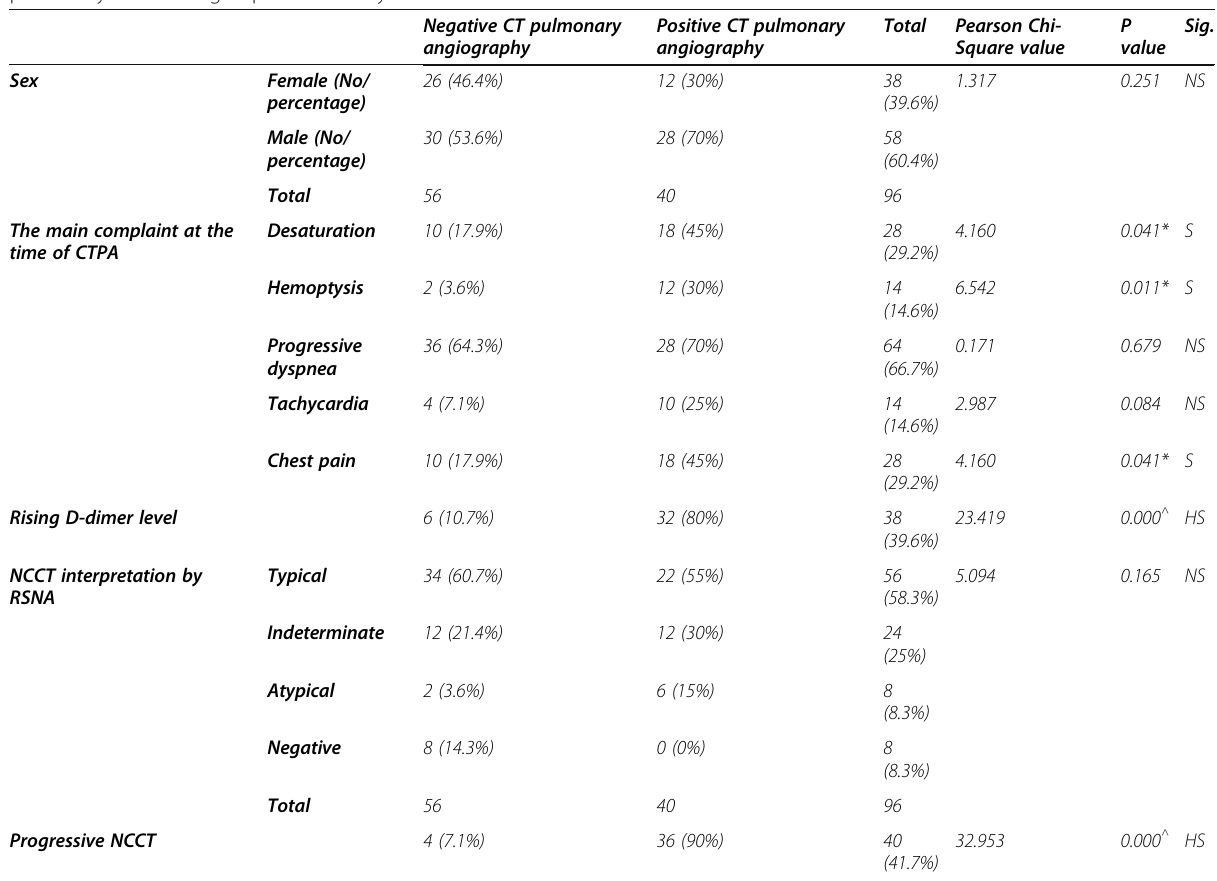
Table 1 Illustrate the incidence and the relation between the patients ’ sex, main complaint at the time of CTPA scanning, rising D- dimer level, CT interpretation according to RSNA criteria, and the progressive CT findings between the negative and positive pulmonary embolism groups under